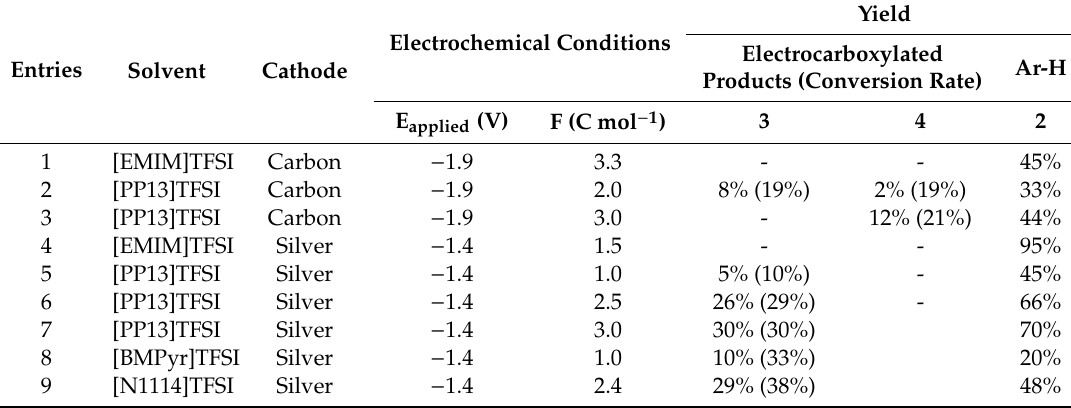
Table 2. Results of the electrocarboxylation of 1